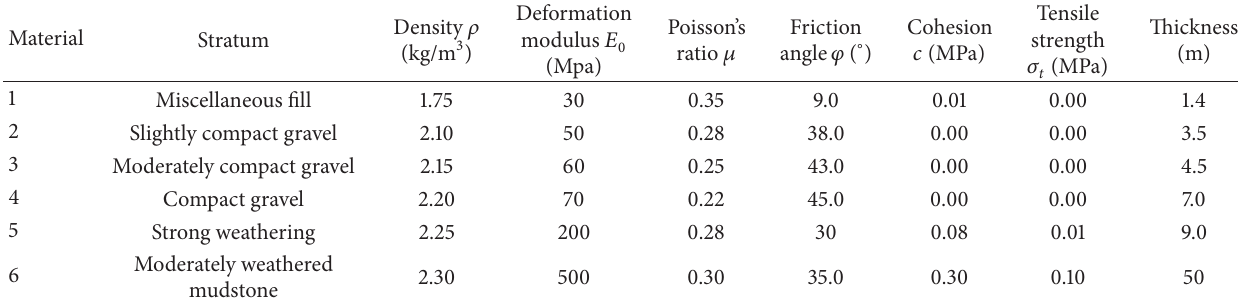
Table 1: Geomaterial parameters table.